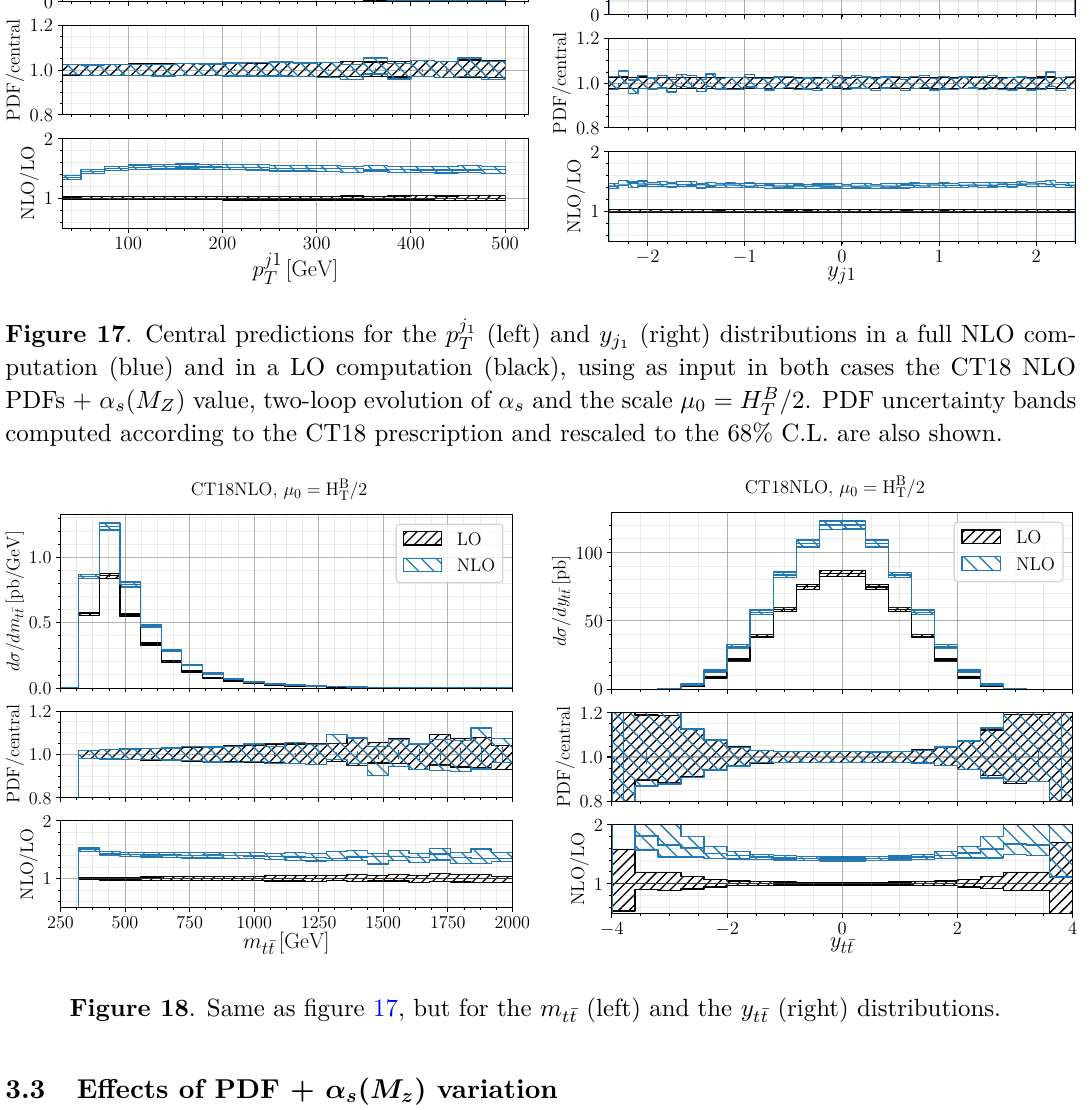
Figure 18 . Same as figure 17, but for the m